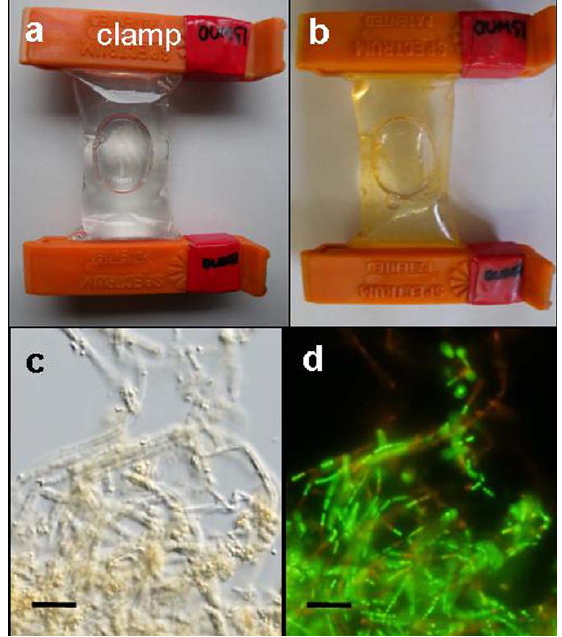
Figure 1. Dialysis tube bags and light micrographs of growing OUMS1 cells and their associated sheaths in groundwater; ( a ) A dialysis tube bag containing a small aliquot of a cell suspension swelled immediately after immersion into the container filled with running groundwater; ( b ) A yellowish-orange-colored bag with coagulated cells and sheaths in the groundwater after 3 days of incubation; ( c ) A light micrograph of the coagulated cells and sheaths in the groundwater after 3 days of incubation; ( d ) Green (viable) and red (dead) cells in (c) were detected by specific live/dead staining. Scale bar = 10 μ m in (c,